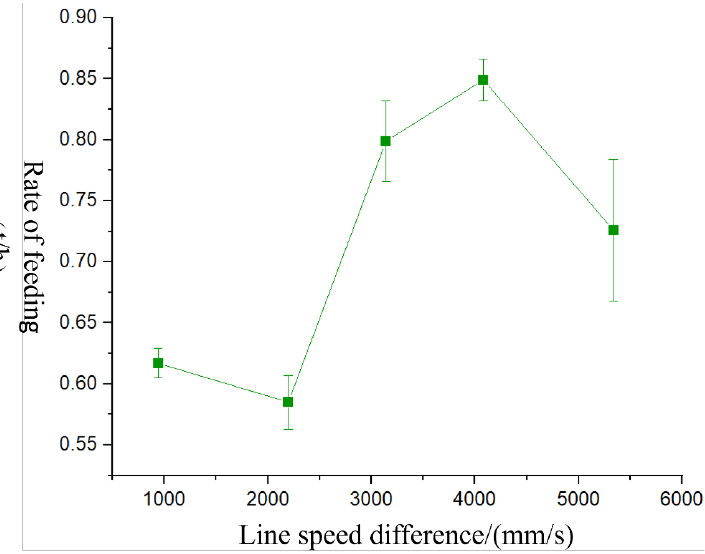
Figure 7. The result of single factor experiments.